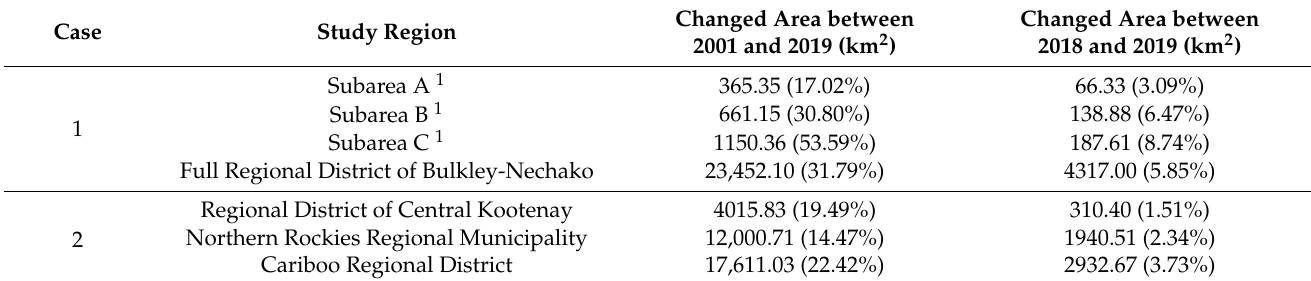
Table 3. Summary of the total changed area across all LC classes for each experimental study region between 2001–2019, and 2018–2019. The change summaries are a summation of net change area for each LC class from the real-world LC data between 2001 and 2019, and 2018 and